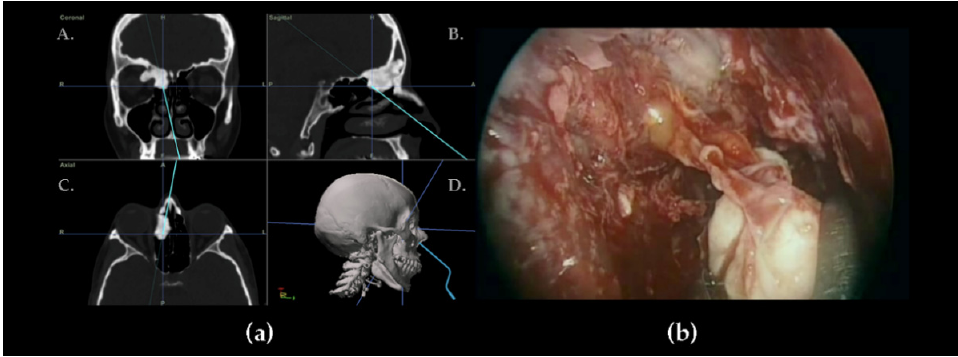
Figure 10. Navigation-guided endoscopic approach for ethmoid–orbital osteoma. ( a ) Navigation system screenshot showing an osteoma’s identification with a navigation pointer: A. coronal view, B. sagittal view, C. axial view, D. 3D reconstruction. ( b ) Endoscopic view during the osteoma’s removal via the trans-nasal approach.